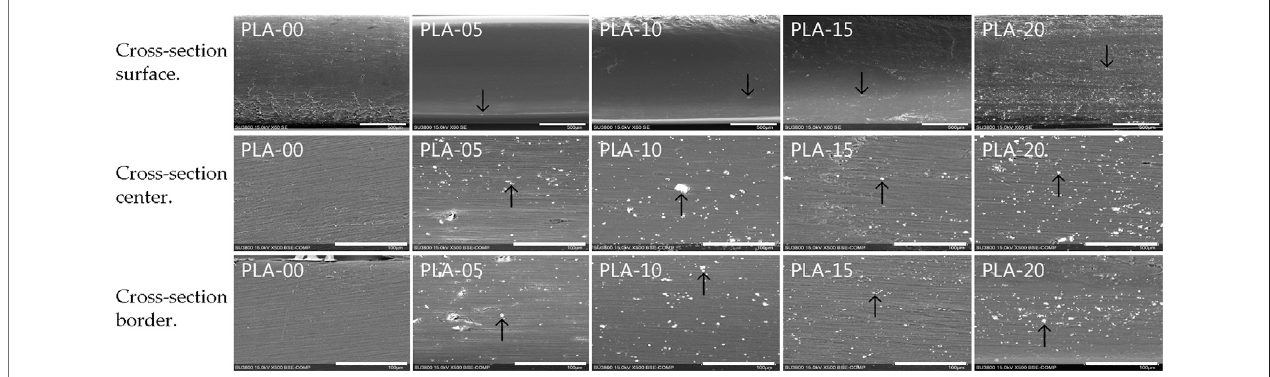
FIGURE 1 | SEM micrographs of the different PLA/ β -TCP fi laments. Three sections in each fi lament show the amount of β -TCP microparticle agglomeration with somemacroparticlesthroughthe fi laments.Cross-sectionsurfaceimages ’ scalebaris500 µm.Blackarrowsindicate β -TCPparticles.Cross-sectioncenterandborder images ’ scale bar is 100